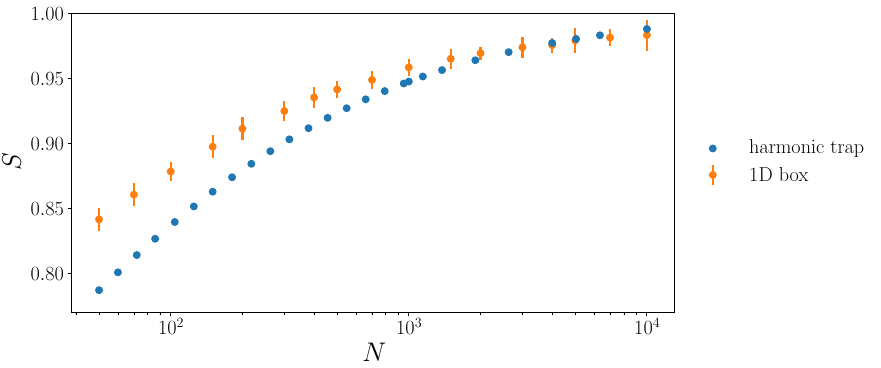
Figure 5: Ratio S between the peak fluctuations in a microcanonical and a canonical ensemble calculation as a function of atom number for a 1D harmonic trap and a 1D box with periodic boundary conditions. The results for the 1D harmonic trap are obtained from an exact calculation (see text). In the case of the 1D box potential, the FSS method was